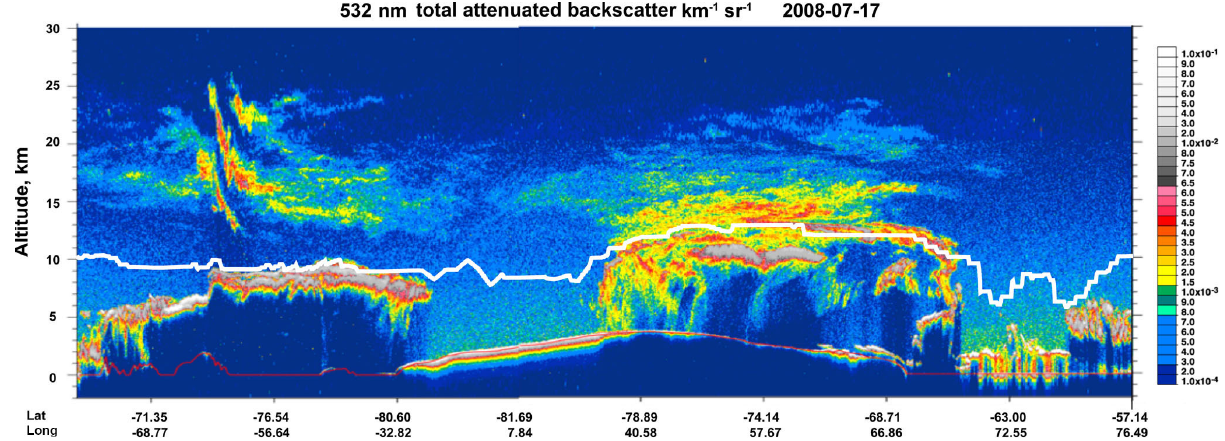
Figure 2. Orbital curtain of CALIOP 532nm total attenuated backscatter coefficient (km − 1 sr − 1 ) along the single orbit highlighted in green in Fig. 1. The MERRA-2 tropopause height is indicated by the solid white